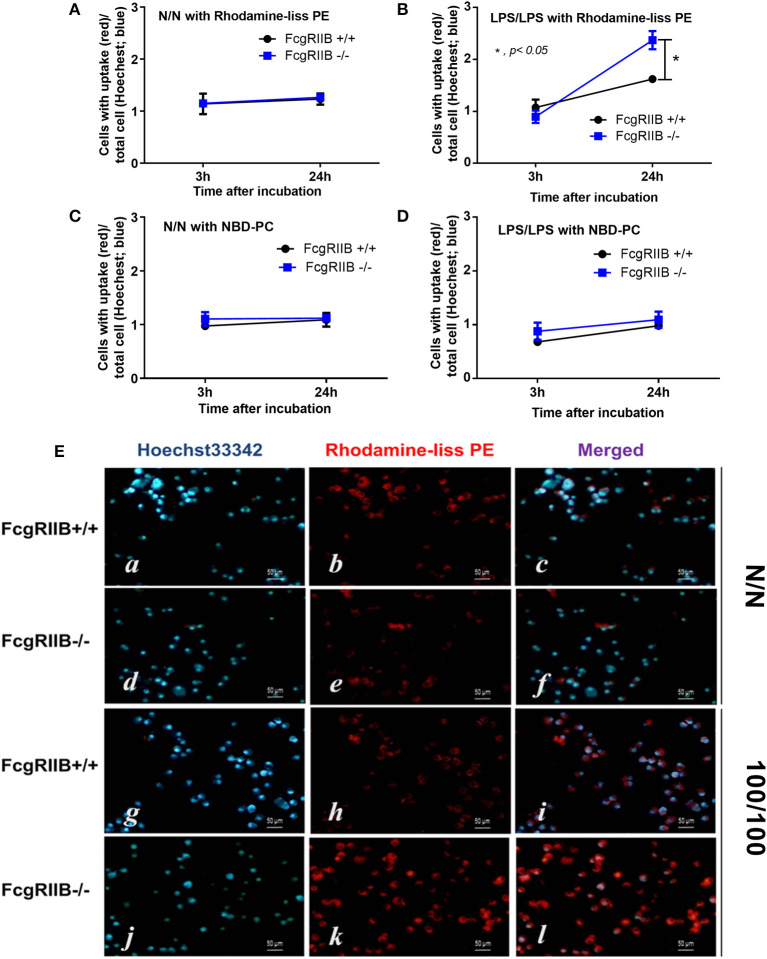
Uptake of lipid analogs Rhodamine-liss phosphatidylethanolamine (Rhodamine-liss PE) (A,B) or fluorescent phosphatidylcholine (NBD-PC) (C,D) normalized by Hoechst 33342 nucleus staining, in FcgRIIB–/– and wild-type (FcgRIIB+/+) macrophages in control (N/N) and LPS-tolerance (100/100) with representative immunofluorescence images (E) are demonstrated (images of NBD-PC uptake are not shown). (Independent triplicate experiments were performed).